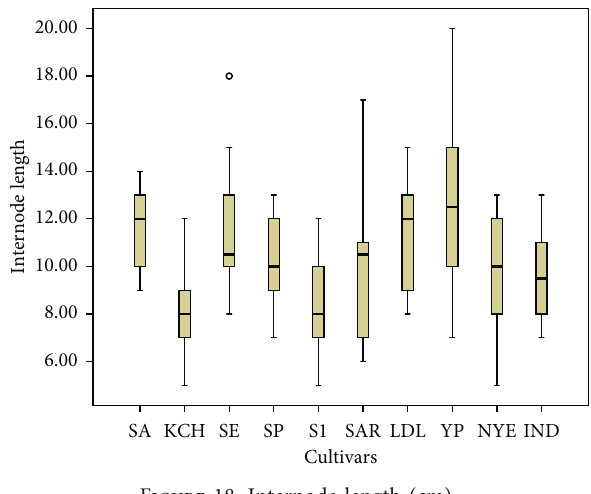
Figure 18: Internode length (cm).